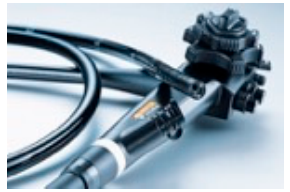
Figure 7. Video colonoscope.